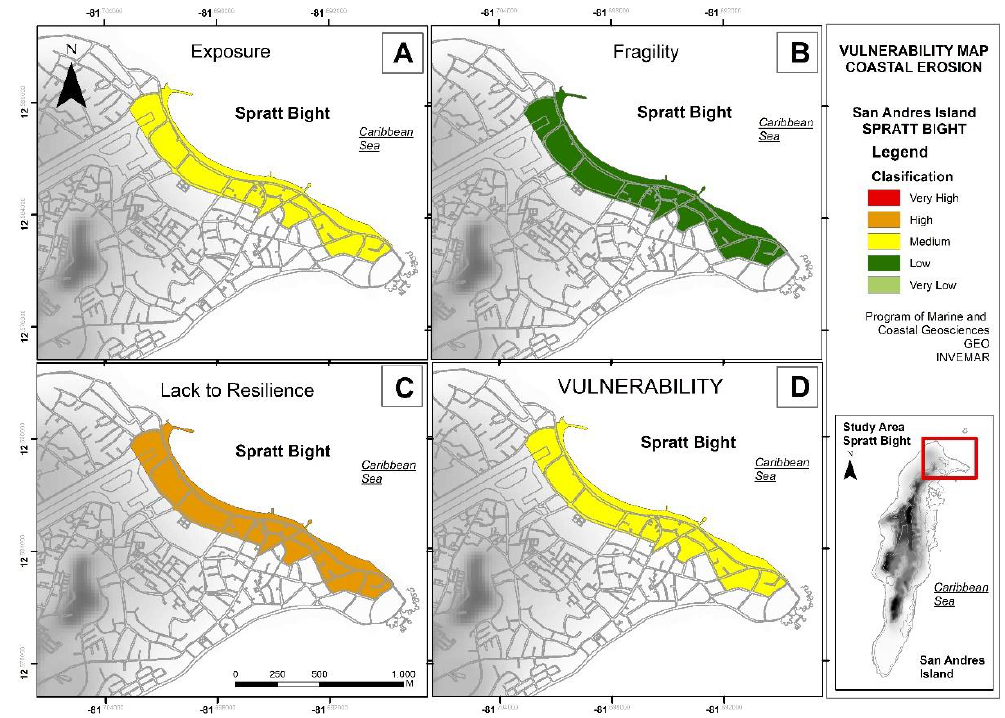
Figure 4. Vulnerability to coastal erosion in Spratt Bight, San Andrés Island, Caribbean coast. ( A ) Exposure, ( B ) Fragility, ( C ) Lack of Resilience, and ( D ) Vulnerability.